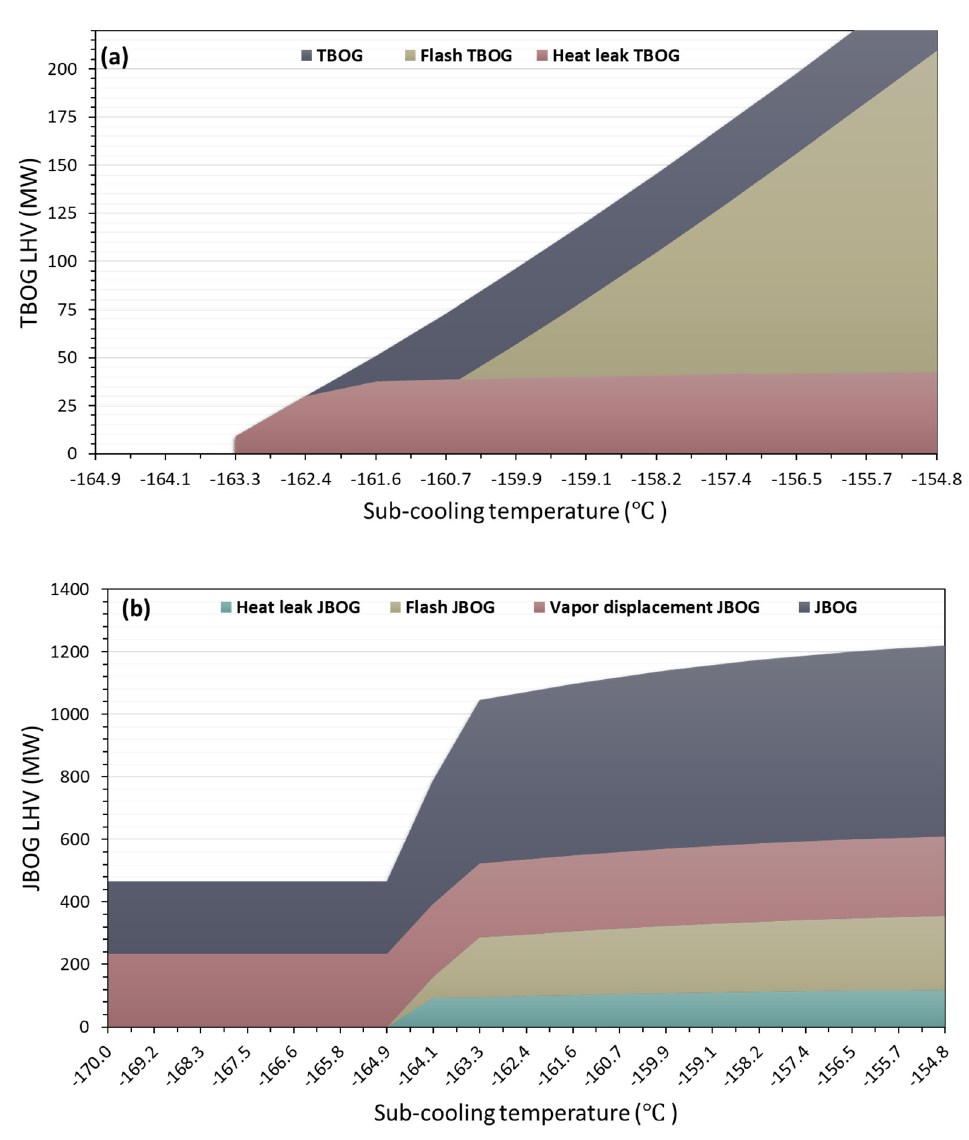
Figure 6. Effect of LNG sub-cooling temperature on ( a ) TBOG LHV, ( b ) JBOG LHV.